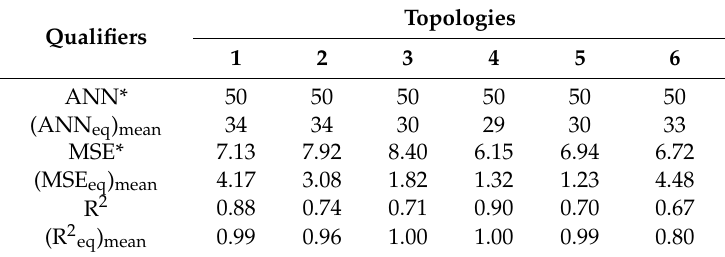
Table 13. Results and optimization of ANN performance.